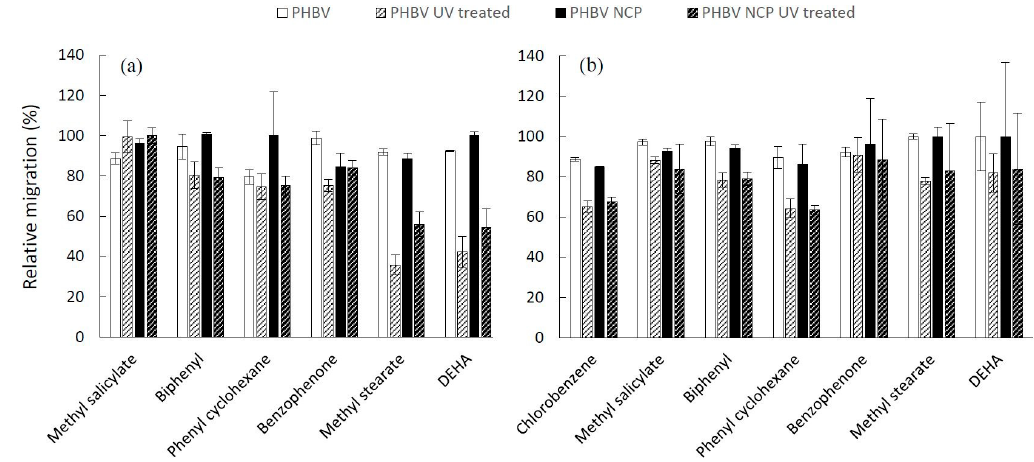
Figure 4. Comparison of the relative migrations of additives from PHBV, PHBV NCP and the corresponding aged materials to 95% ethanol ( a ) and isooctane ( b ) after 10 days of contact.